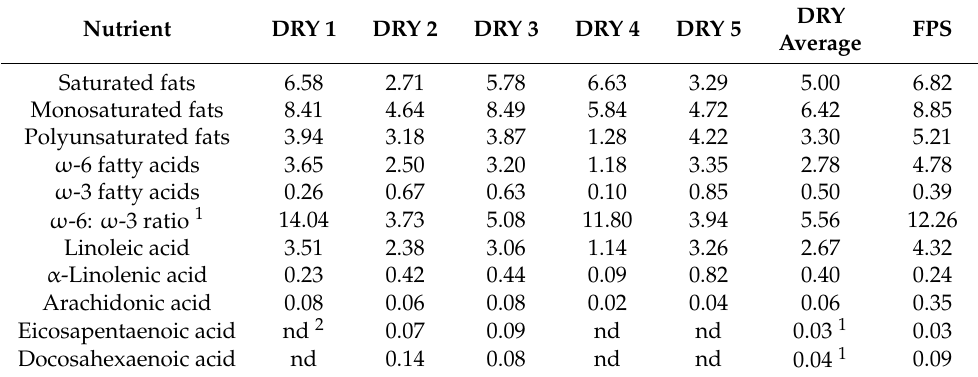
Table 3. Selected fatty acids content (% of dry matter) of experimental diets.